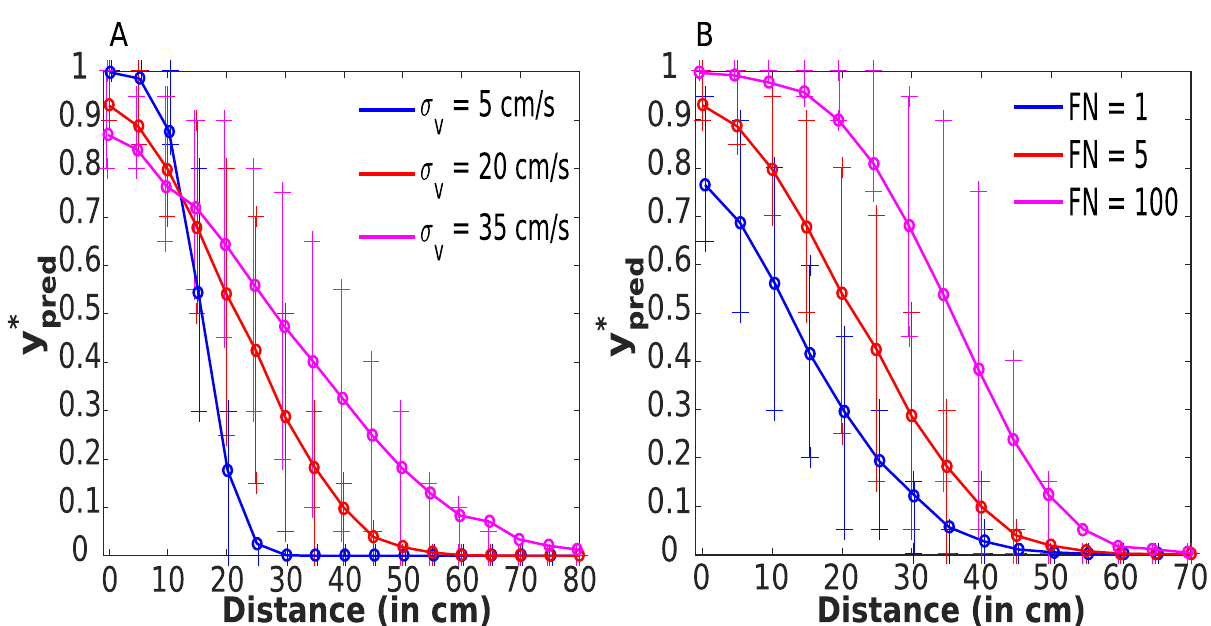
Fig 4. Effect of stimulus uncertainty and the False Negative (FN) penalty parameters. Dependency between the mean of 1000 predicted tactile activations y � (for each distance) and distance x (in centimeters) of the stimuli from the body. The symbols “+” indicate 25th and 75th percentiles T pred which are calculated from 1000 predicted values y � for each distance. (A) The size of PPS and slope of its boundary are modulated by σ pred size of PPS, but only minimally the slope of its boundary, are modulated by FN . Parameters used are in Table 1 (except for σ v in (A) and FN in (B)). See S2 Fig—the right upper panel—for a version of subfigure A with FN = FP =